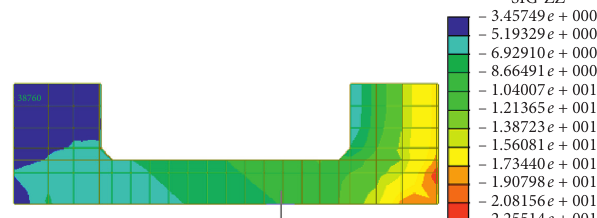
Figure 10: Normal stress of bevel section above 0.6m (MPa).